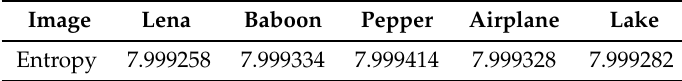
Table 9. Information entropy.